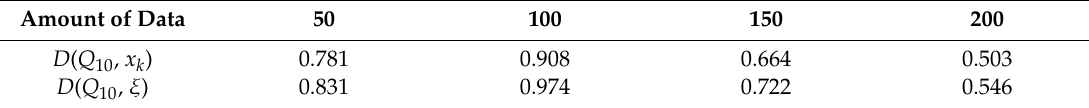
Table 4. Mean errors of D ( Q 10 , x k ) and D ( Q 10 , ξ ) at four